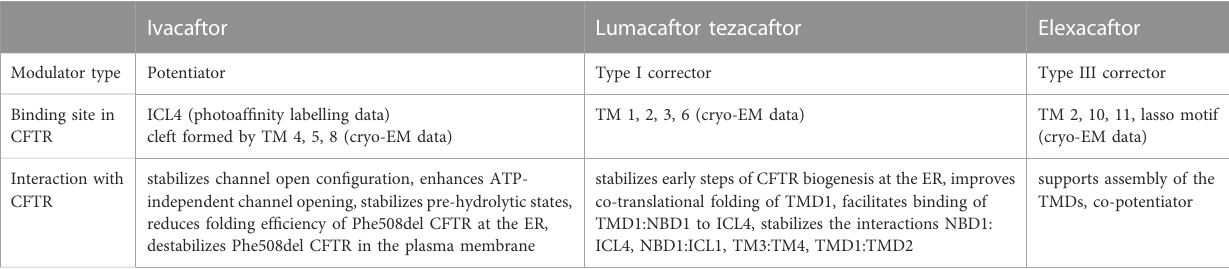
TABLE 1 Molecular action of the approved modulators on CFTR structure and